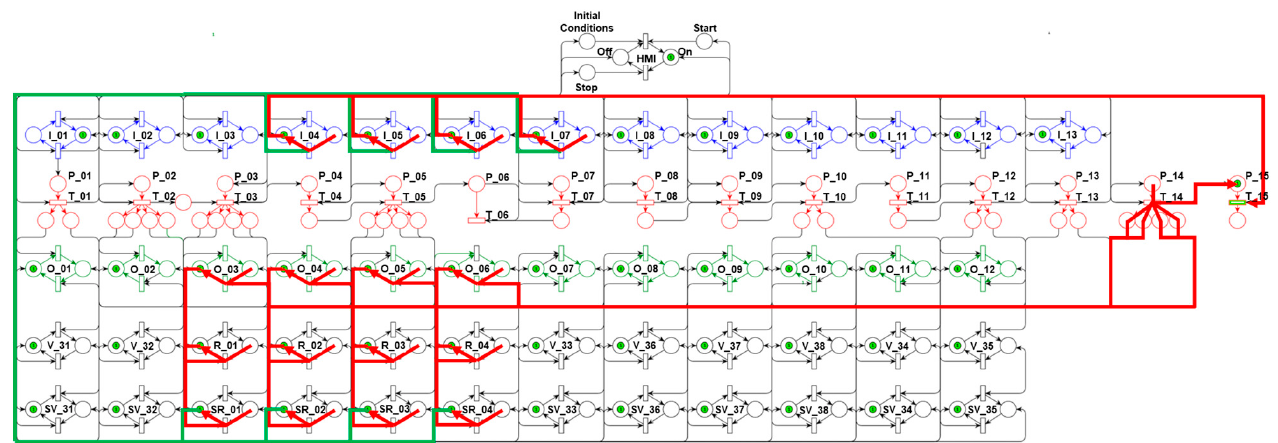
Figure 38. Algorithm’s 15th step—Deactivate regulators.